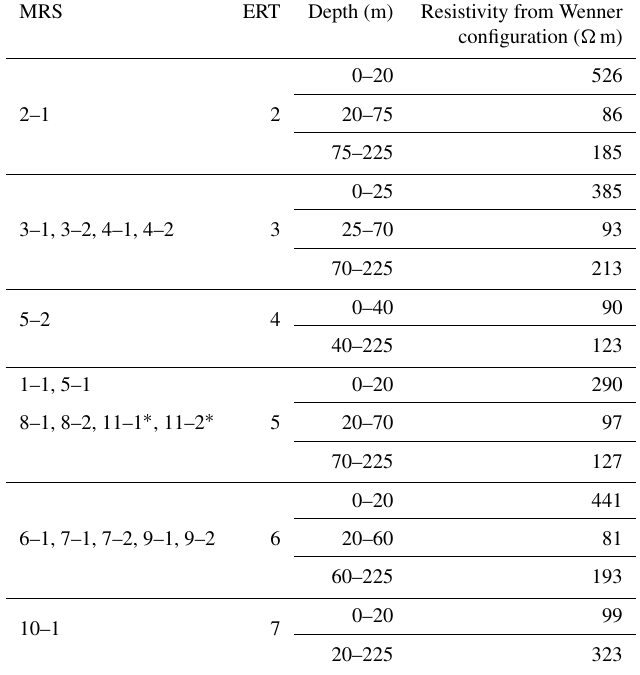
Table A6. Geoelectrical models used for MRS